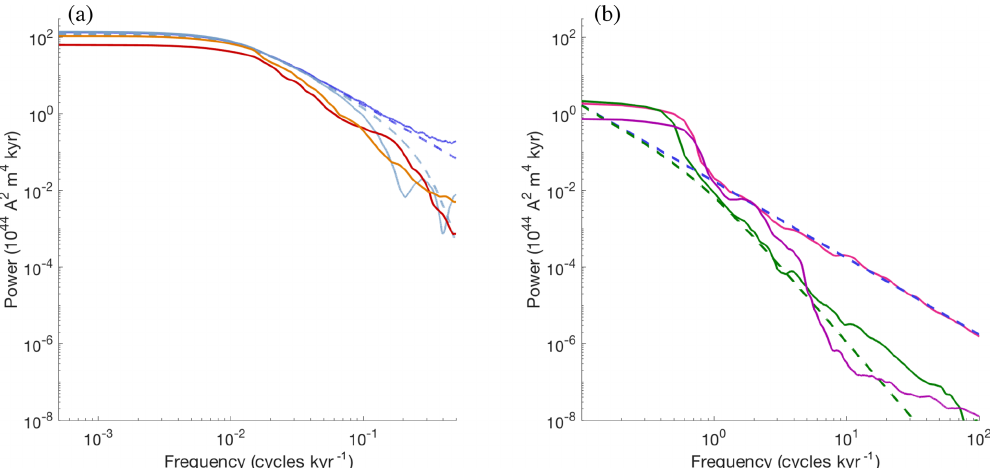
Figure 3. Power spectral densities of the model with nominal parameter values. (a) Myr model : a PSD of a 50Myr simulation with the Myr model is shown as a solid dark blue line. The corresponding theoretical PSD of the linear model is shown as a dashed dark blue line. A PSD of a 50Myr simulation with the Myr model and high-frequency roll-off is shown as a solid light blue line. The corresponding theoretical PSD of the linear model is shown as a dashed light blue line. The PDSs of Sint-2000 and PADM2M are shown in orange and red. (b) kyr model : a PSD of a 10kyr simulation of the kyr model with uncorrelated noise is shown as a solid pink line. The corresponding theoretical spectrum of the linear model is shown as a dashed blue line. A PSD of a 10kyr simulation of the kyr model with correlated noise is shown as a solid green line. The corresponding theoretical spectrum is shown as a dashed green line. The PDSs of CALS10k.2 is shown in purple. All PSDs are computed by the multi-taper spectral estimation technique of Constable and Johnson